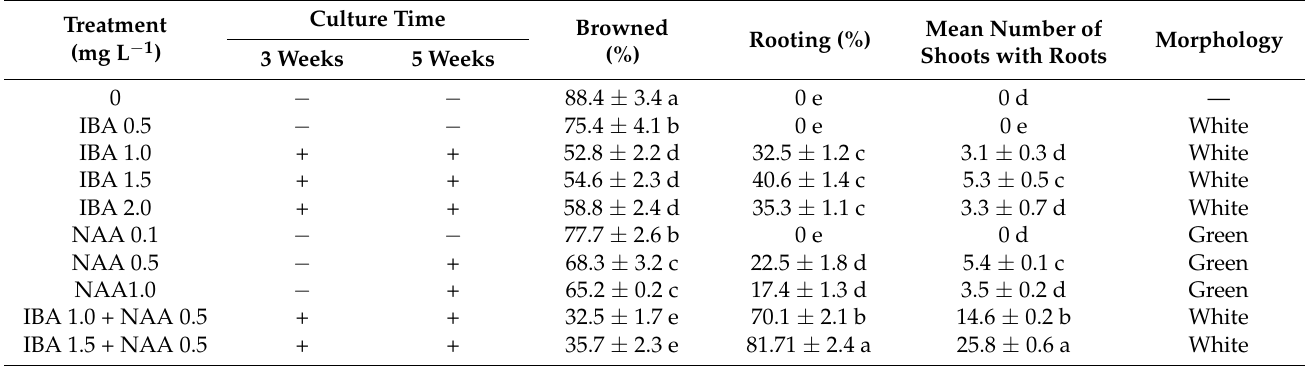
Table 4. Effects of auxins on root induction in A. lupulina .